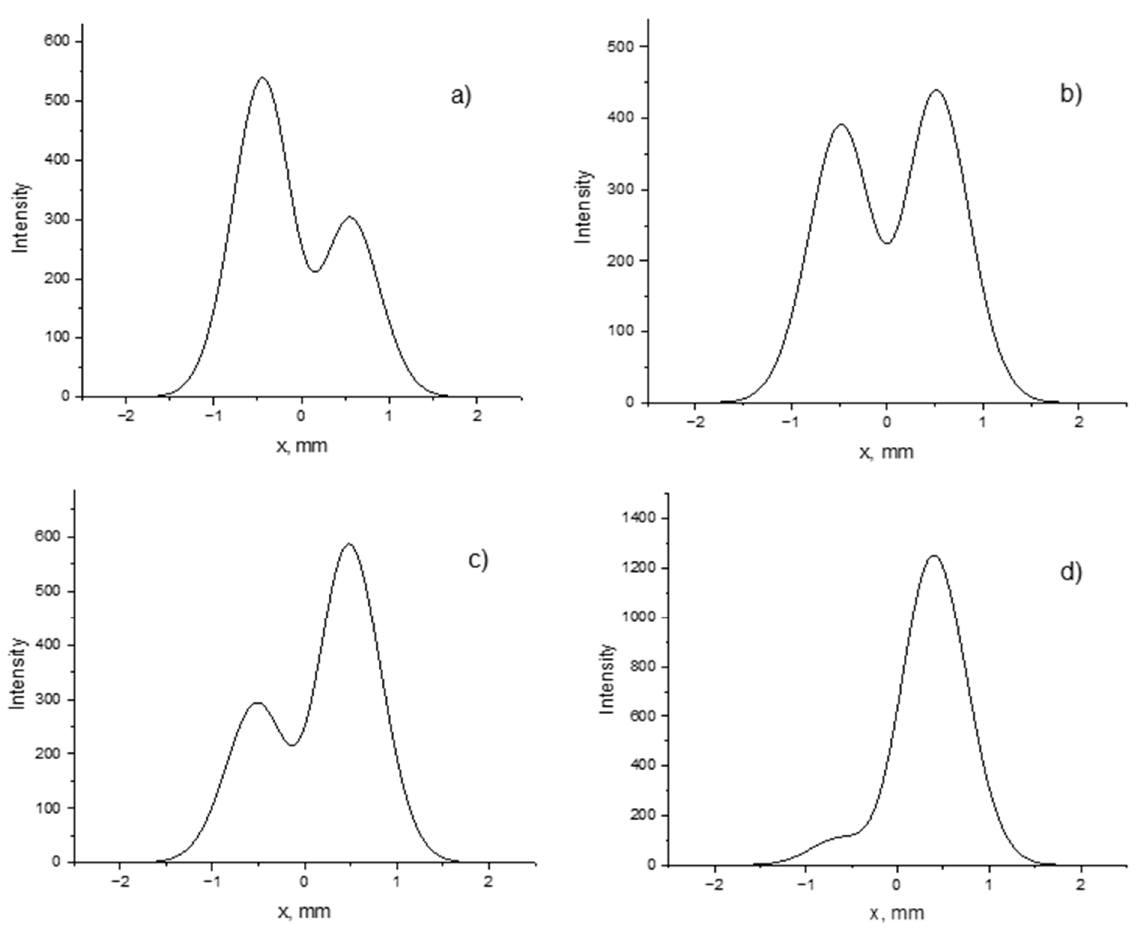
Figure 15. Calculated intensity profiles of the reflected beams from the Ni grating with a period of Λ = 400 nm and depth of h = 80 nm at a distance z = 11 cm. ( a ) θ i = 33.47 ◦ ; ( b ) θ i = 33.53 ◦ ; ( c ) θ i = 33.58 ◦ ; ( d ) θ i = 33.73 ◦